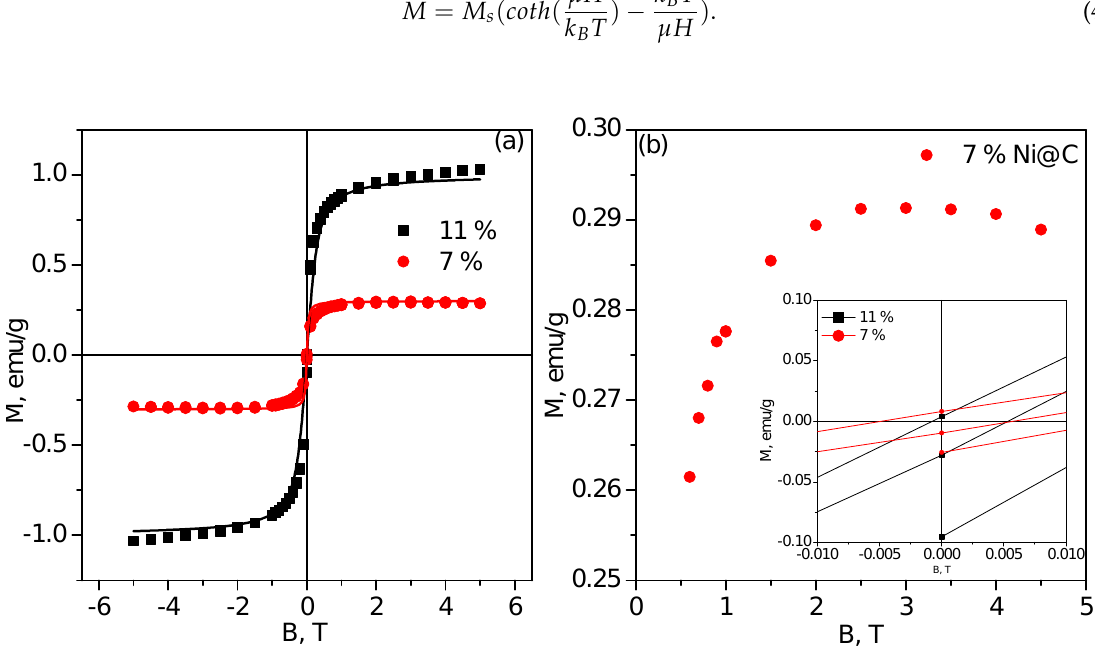
Figure 6. Field dependence of the magnetization of samples with different concentrations of Ni@C at 300 K ( a ). Diamagnetic effect of the sample with 7 vol % of Ni@C at high magnetic fields ( b